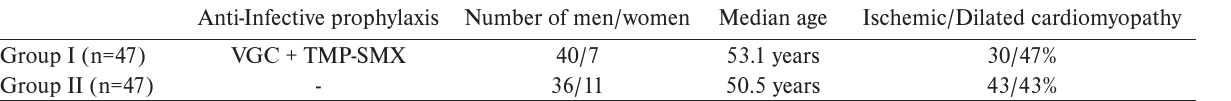
Table 1. Patient characteristics data.